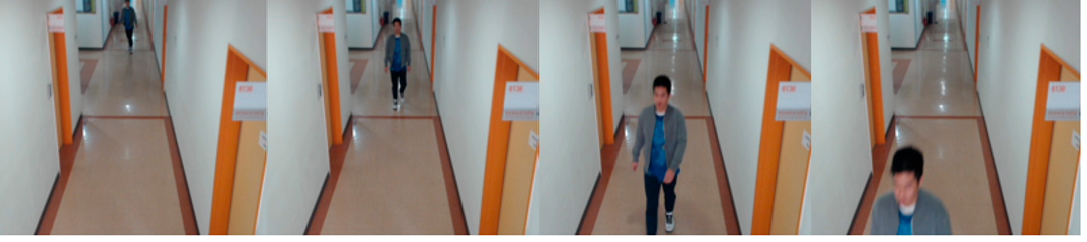
Figure 10. Example images from DFB-DB1 taken by the Logitech C920 camera.